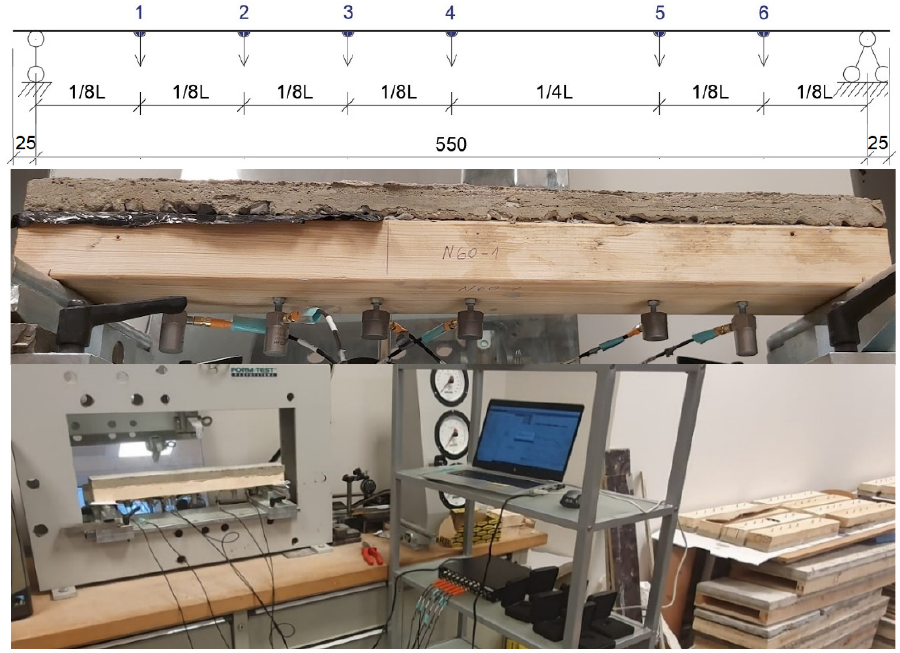
Figure 2. Sensor arrangement scheme and test progress of TCC specimens.